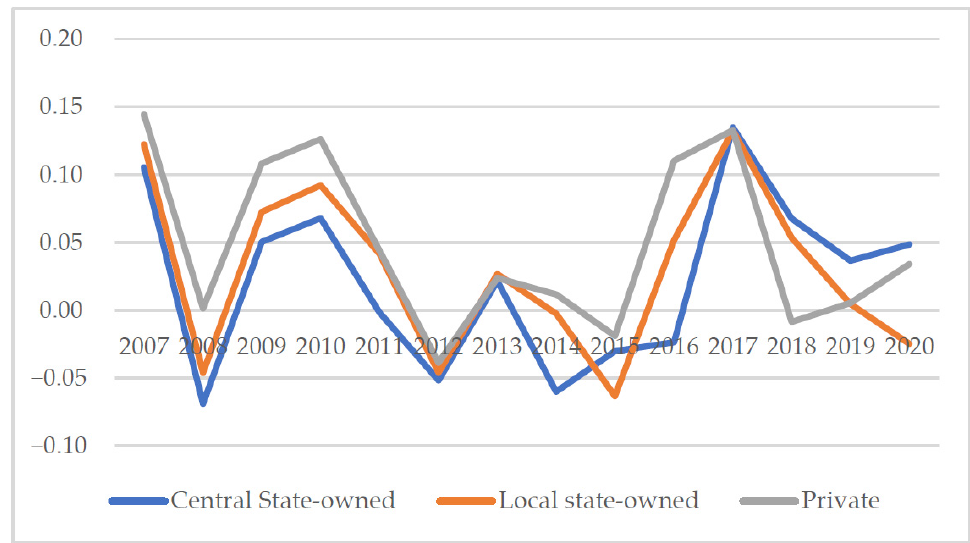
Figure 2. Change chart of TFP growth rates by ownership enterprises.